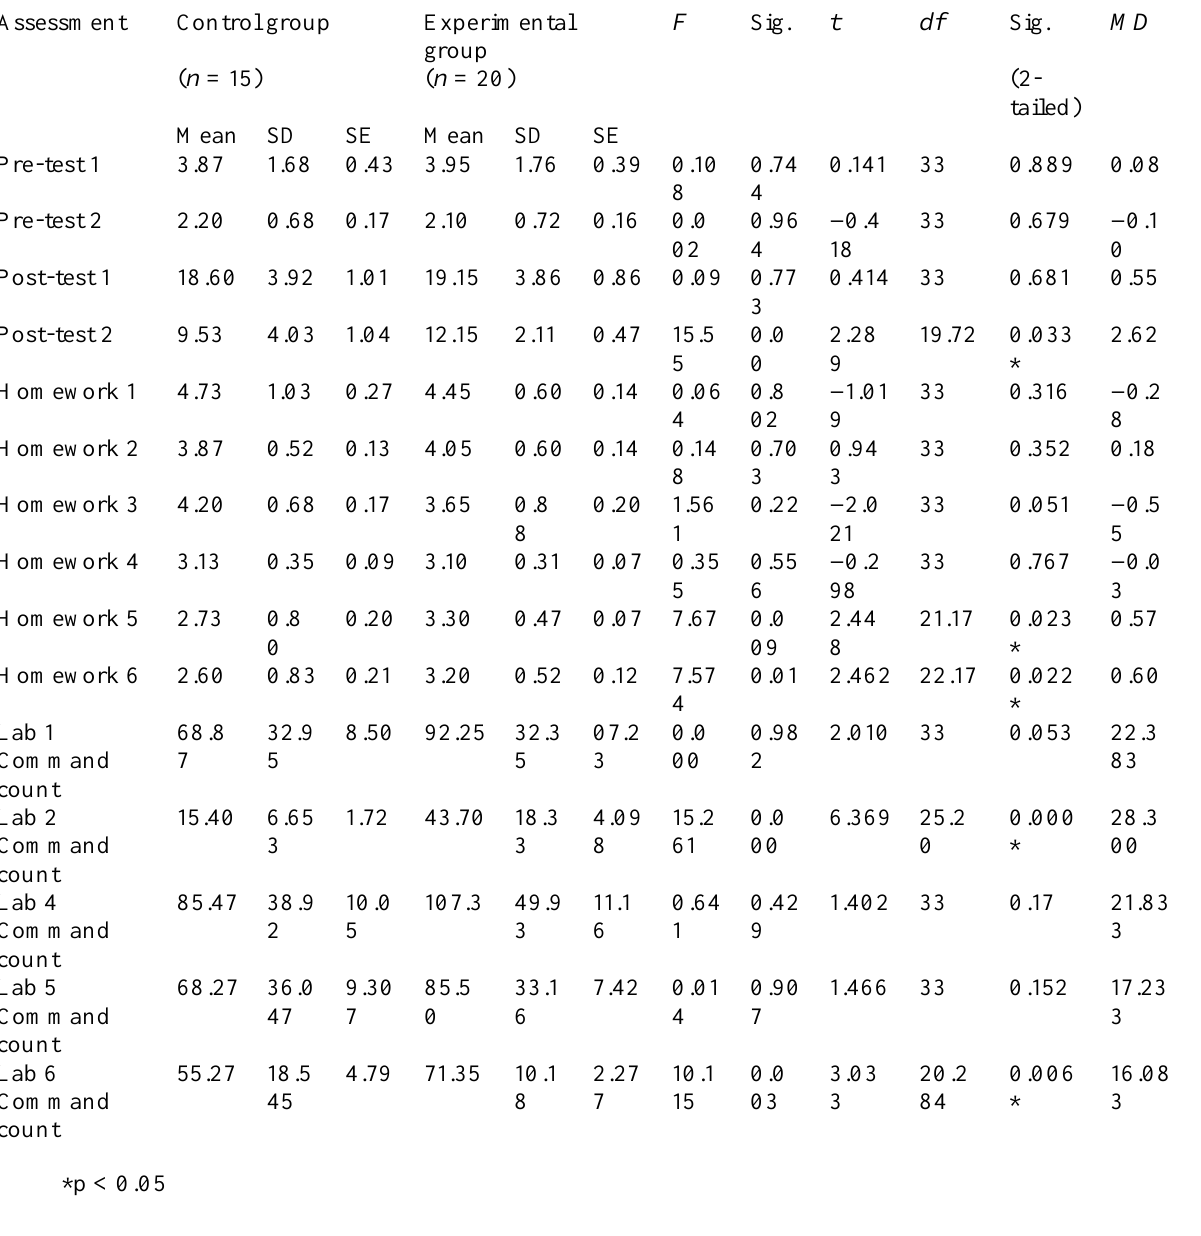
Results of the Assessment and